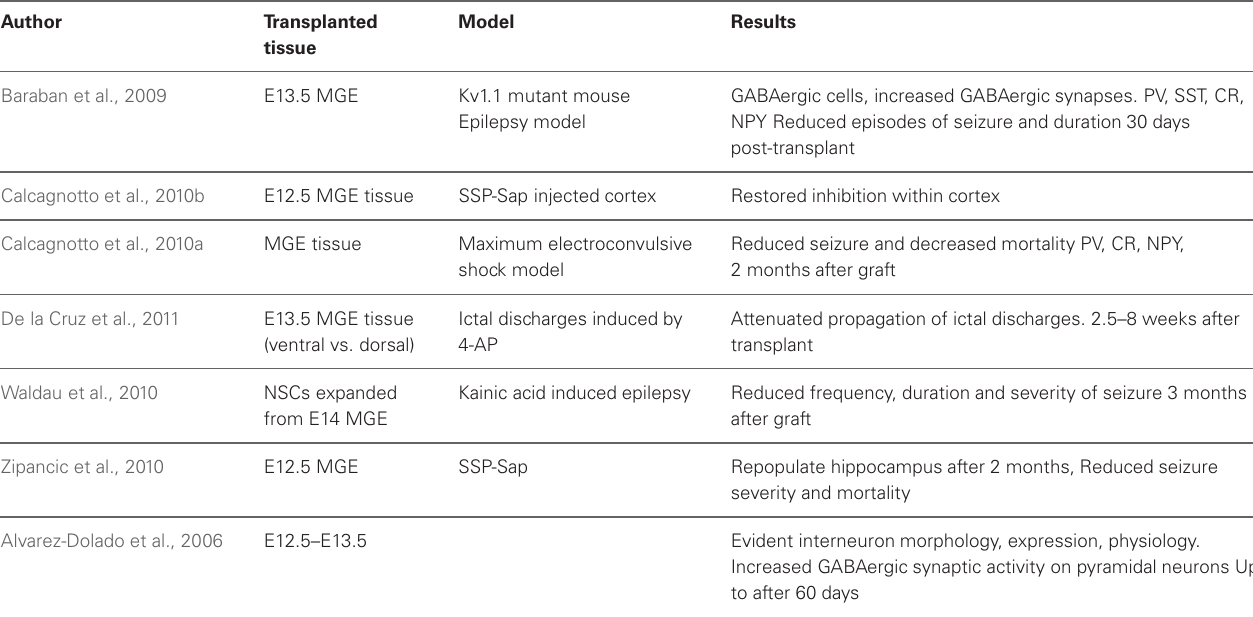
Table 1 | Transplantation of fetal-derived interneuron